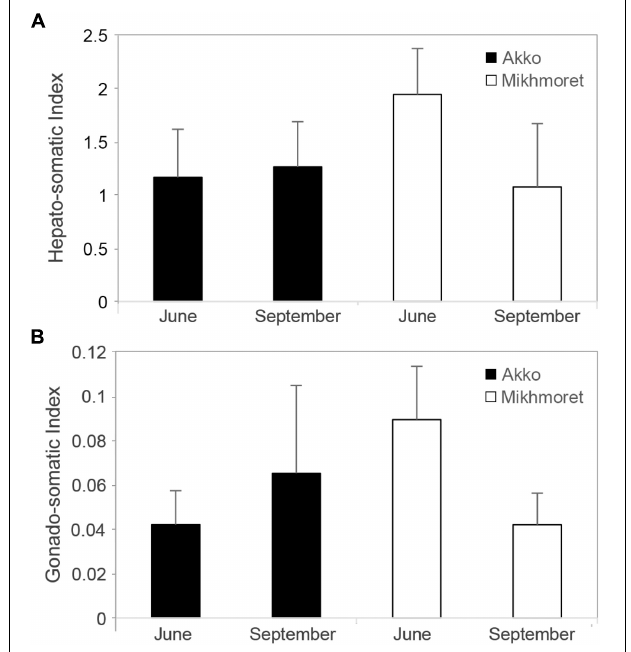
FIGURE 8 | Microcosmus exasperatus’ hepato-somatic index (A) (Mean ± SD) and gonad-index (B) from June and September 2016 and 2017 samples, from Akko and Mikhmoret ( n =